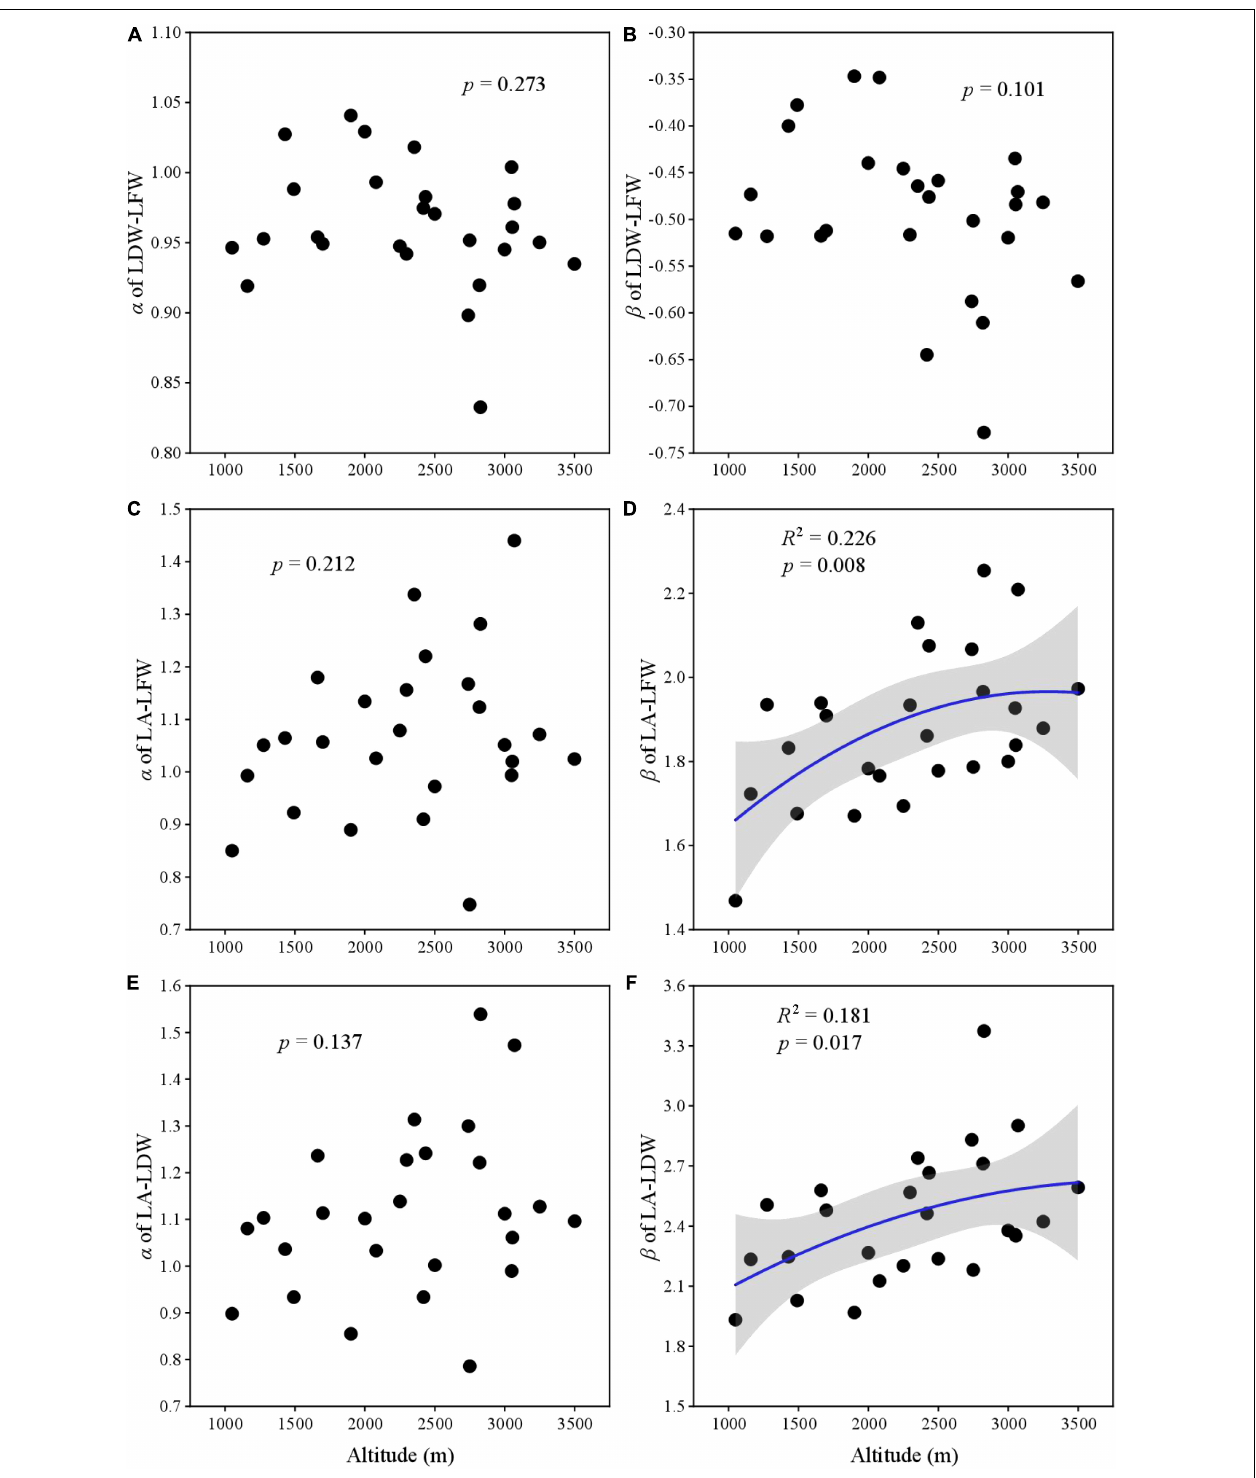
FIGURE 4 | The relationship between scaling exponent and normalization constant with elevation gradient. (A) Scaling exponent of LDW and LFW; (B) normalization constant of LDW and LFW; (C) scaling exponent of LA and LFW; (D) normalization constant of LA and LFW; (E) scaling exponent of LA and LDW; and (F) normalization constant LA and